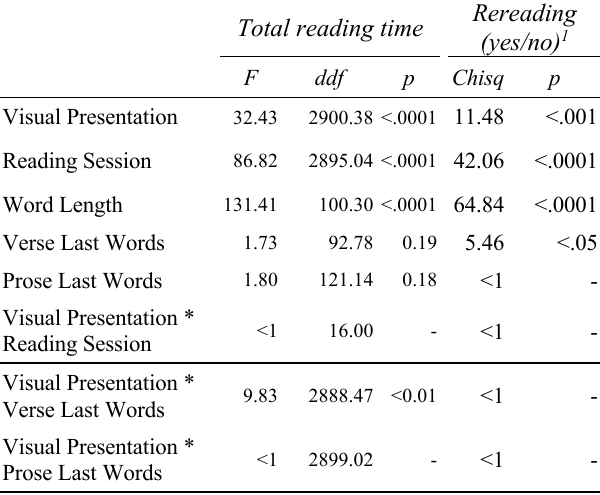
Table 4. Mixed model parameters for two eye tracking measures reflecting (also) later comprehension processes (lexical